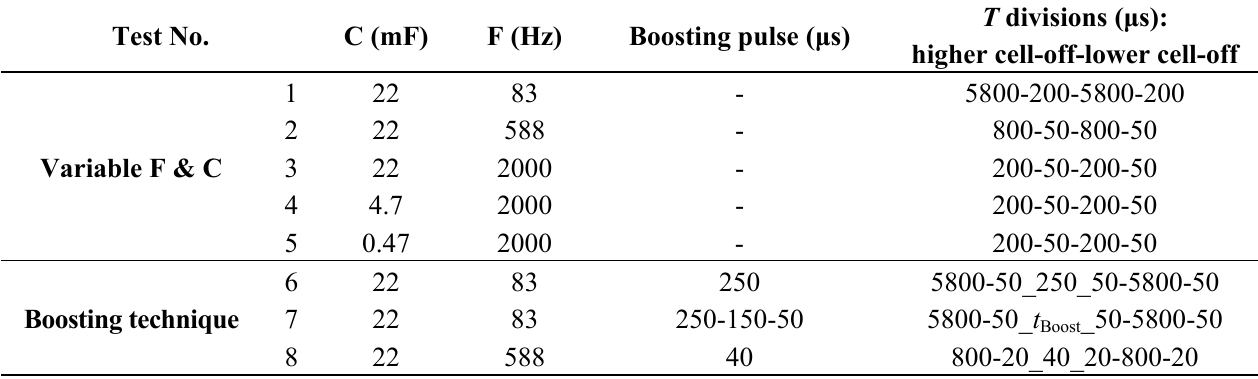
Table 2. Experimental balancing tests, two 2.3 A·h sequences using SSC. Test No.